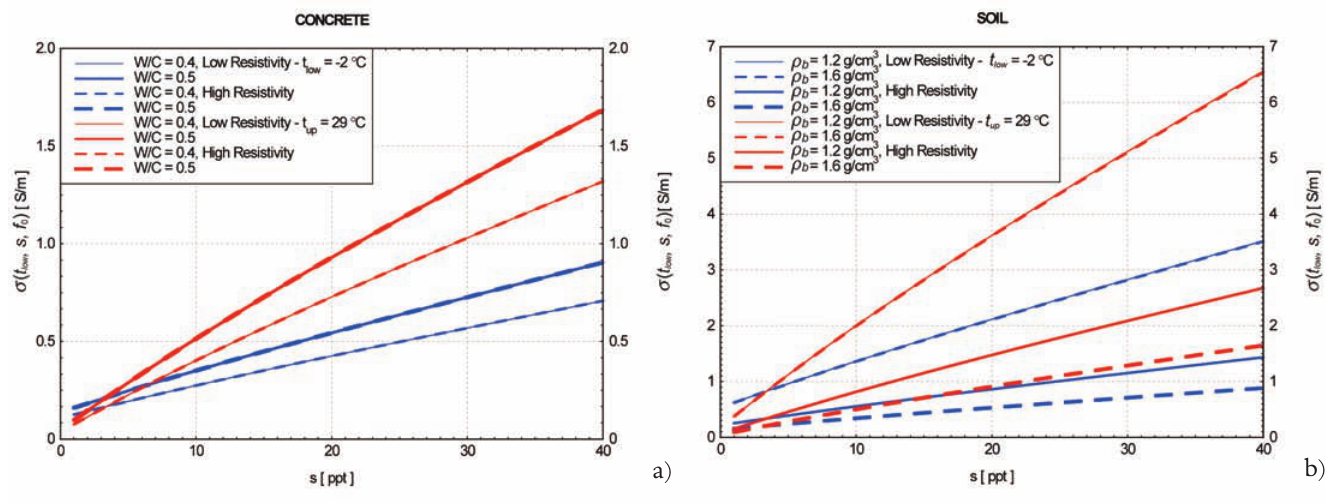
Figure 1. A material medium analyzed at low and high temperatures ( t = –2 ºC, t = 29 ºC) and within the HF band ( f < 1 GHz). The medium can be low up 0 concrete (a) or terrestrial soil (b). Concrete [Cheeseman et al. 1998]: a three component mixture of water [Klein and Swift 1977], air (relative dielectric permittivity, f = 1), and solid (ordinary Portland cement) phases; fine or coarse textured, with a high or low water to cement ratio, respectively ( W / C = A = 4-7. Soil: a three component mixture of water, air, and solid 0.4-0.5); and high or low electrical resistivity, respectively, with dielectric permittivity f S (mineral f = 3.9 or organic f = 5) phases, with low or high thickness of the bonded water shell ( d ( m )=1/ m , m = 10 7 -10 9 cm –1 ); fine or coarse textured, S S BW = 1.2-1.6 g/cm 3 ); and high or low resistivity, respectively, composed of pure clay minerals (apparent respectively, with low or high loose bulk density ( t b particle density, t = 2.65 g/cm 3 ) or even organic matter (OM = 10%). The Sen et al. [1981] and De Loor [1964] theoretical models overlap well with the p ,s , s , f ), in units of S/m, as a function of the salinity s , in the range s ! [ s ], with Archie [1942] empirical law. Plots of the electrical conductivity v ( t low, up low up 0 s = 1 ppt and s = 40 ppt, for both the concrete and low up